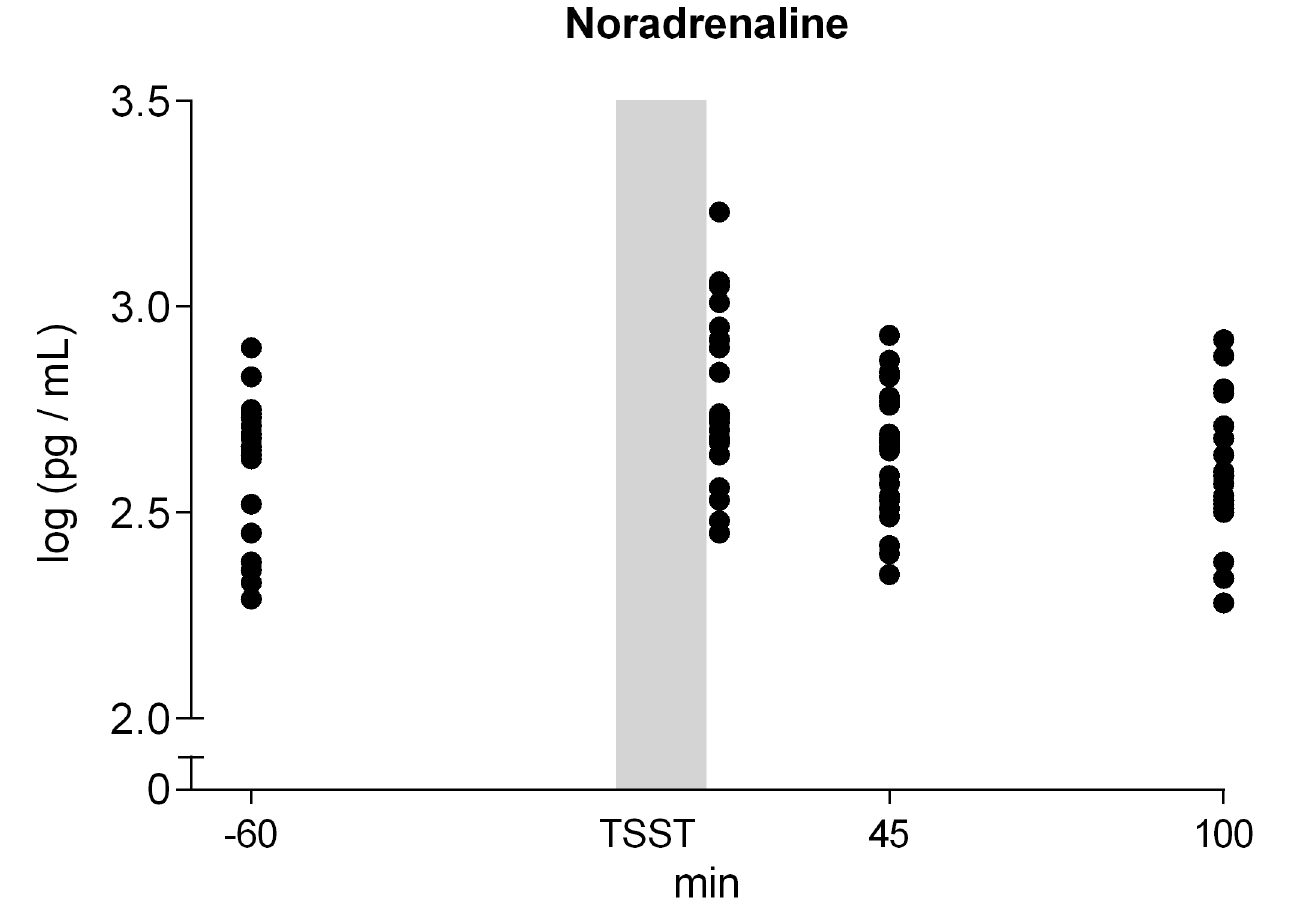
Fig 2. The distribution of Noradrenaline response to the Trier Social Stress Test among individuals.